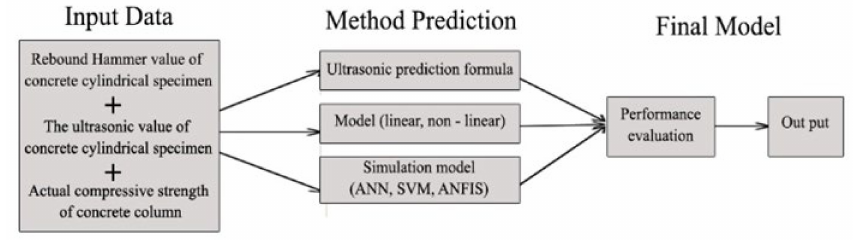
Figure 2. Model development.